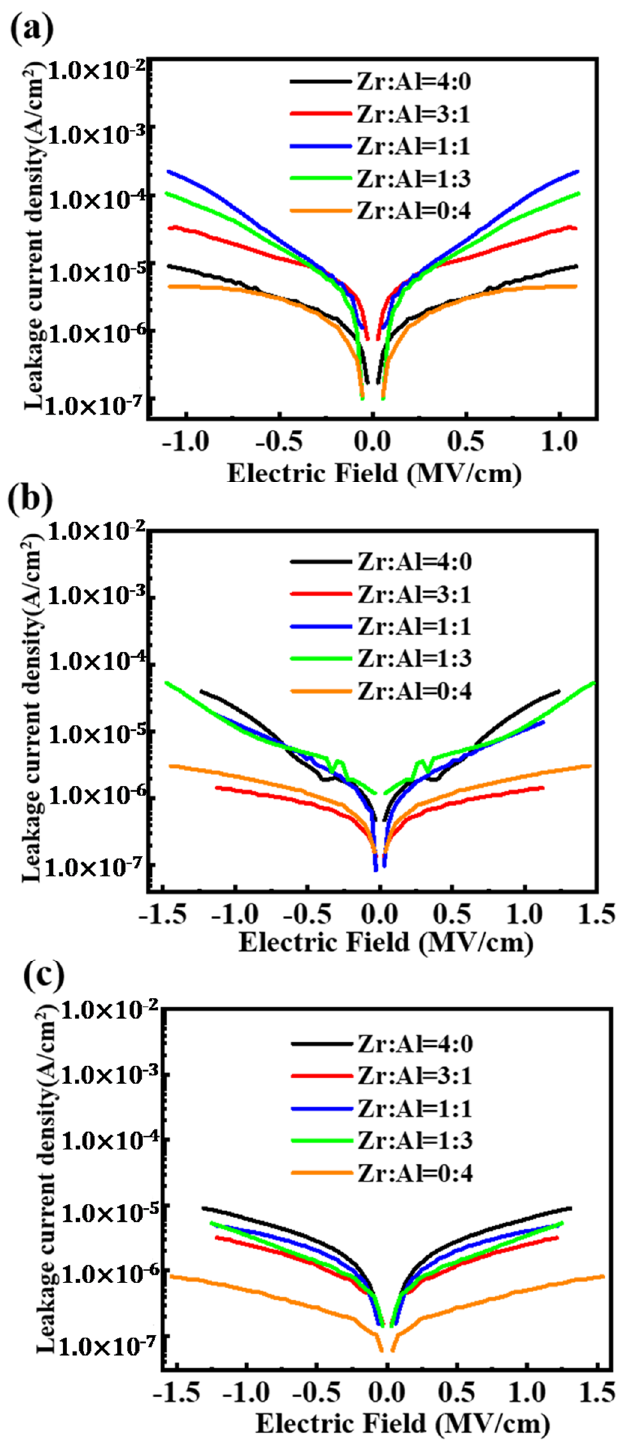
Figure 7. The leakage current densities of the ZAO films with altering ratios annealed at: ( a ) 300 °C; ( b ) 400 °C; and ( c ) 500 °C. 400 ◦ C; and ( c ) 500 ◦